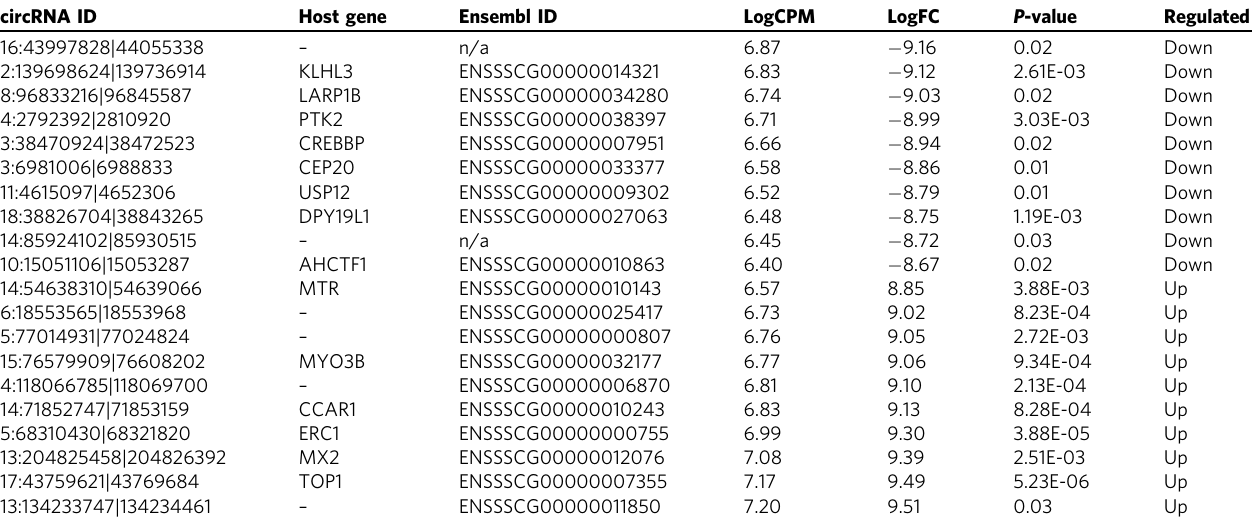
Table 2 The top 20 differentially expressed circRNAs. circRNA